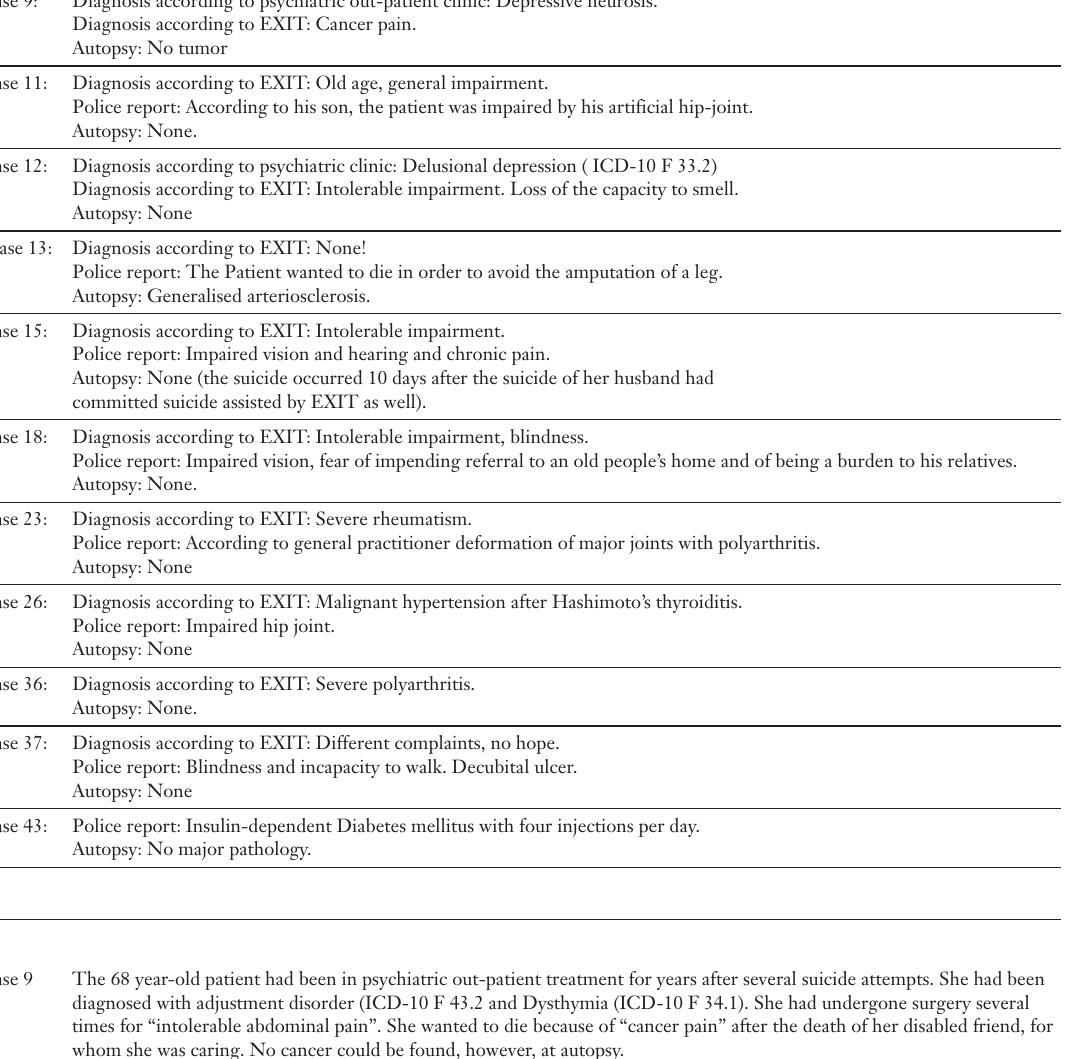
Synopsis of the psychiatric history of six “EXIT”- suicide-cases.